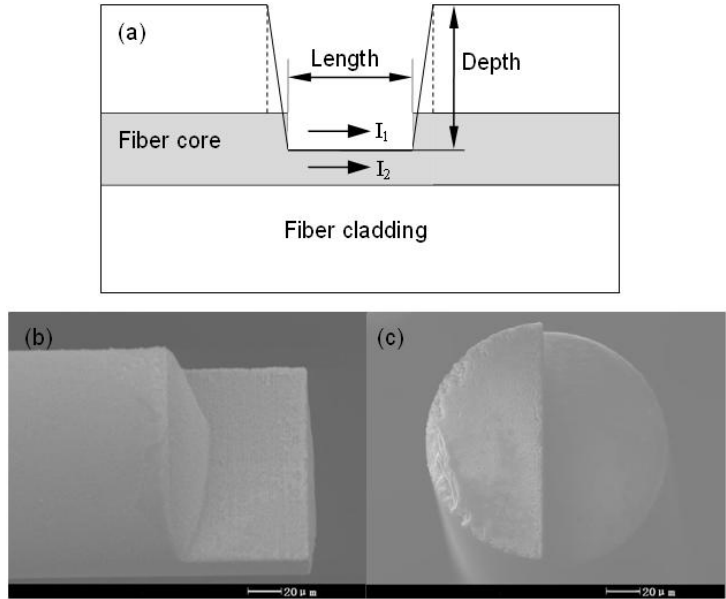
Figure 2. Trench fabricated by fs laser pulses. (a) Structural illustration. (b) Side view (a half part). (c) Cross